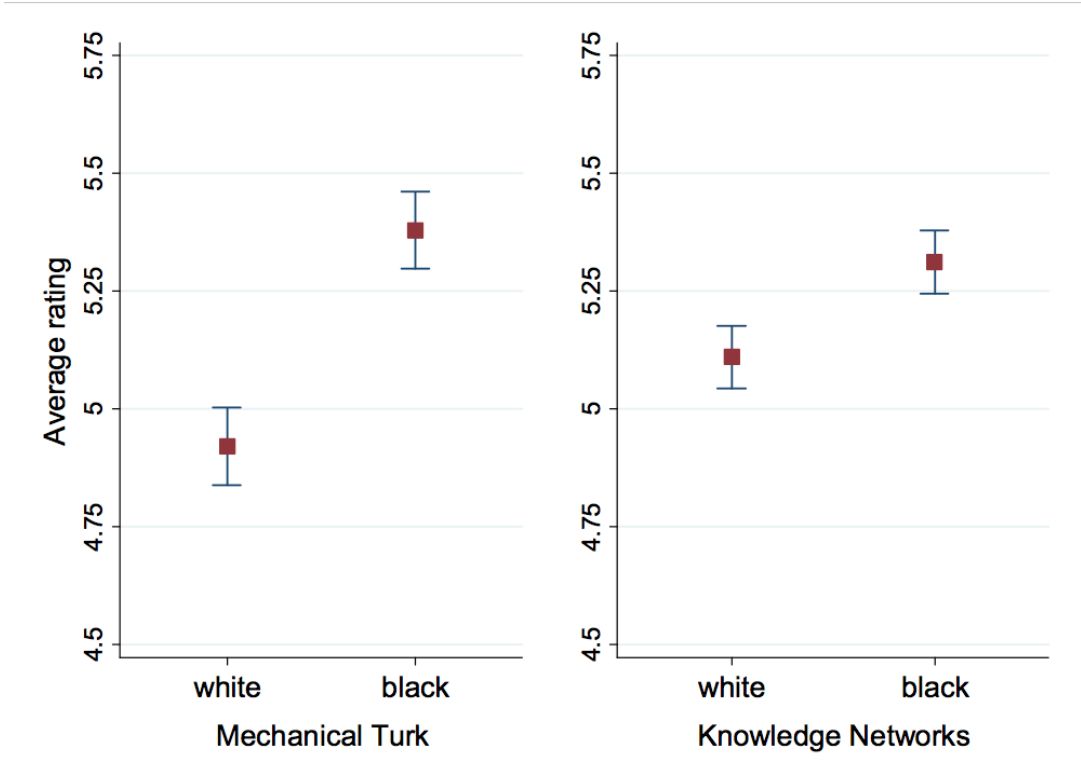
Figure 4: Differences in results for racial discrimination experiment between MT and KN. “White” and “black” refer to the race of the employee in the